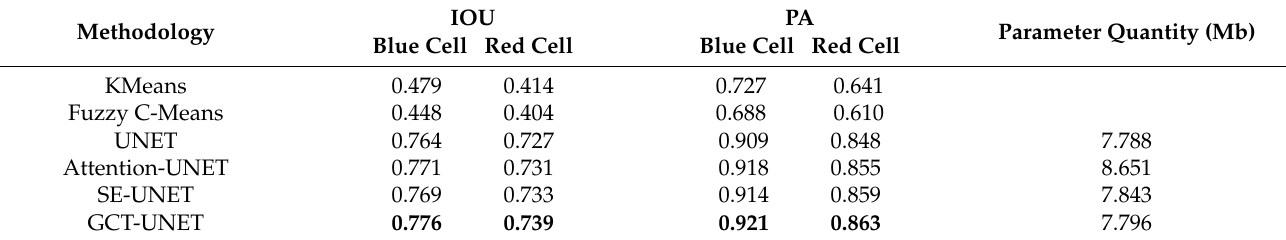
Table 1. Comparison of experimental results of different models.